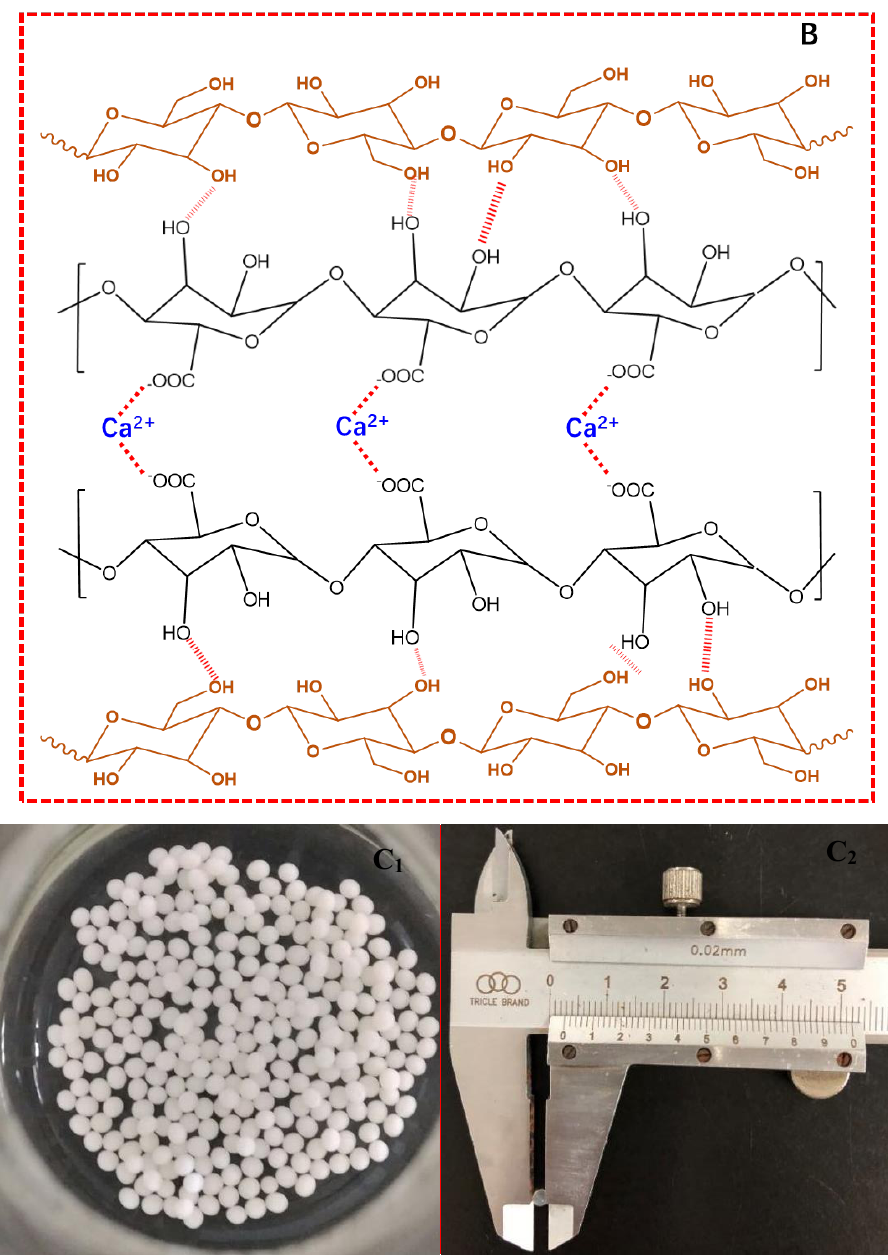
Figure 6. Procedure for the preparation of bacterial cellulose-alginate (BC-ALG) carriers ( A ), the mechanism of the interaction of the components inside ( B ) and pictures of the carriers with immobilized cells ( C 1 , C 2 ). Table 1. The different composition of the BC-ALG carriers.